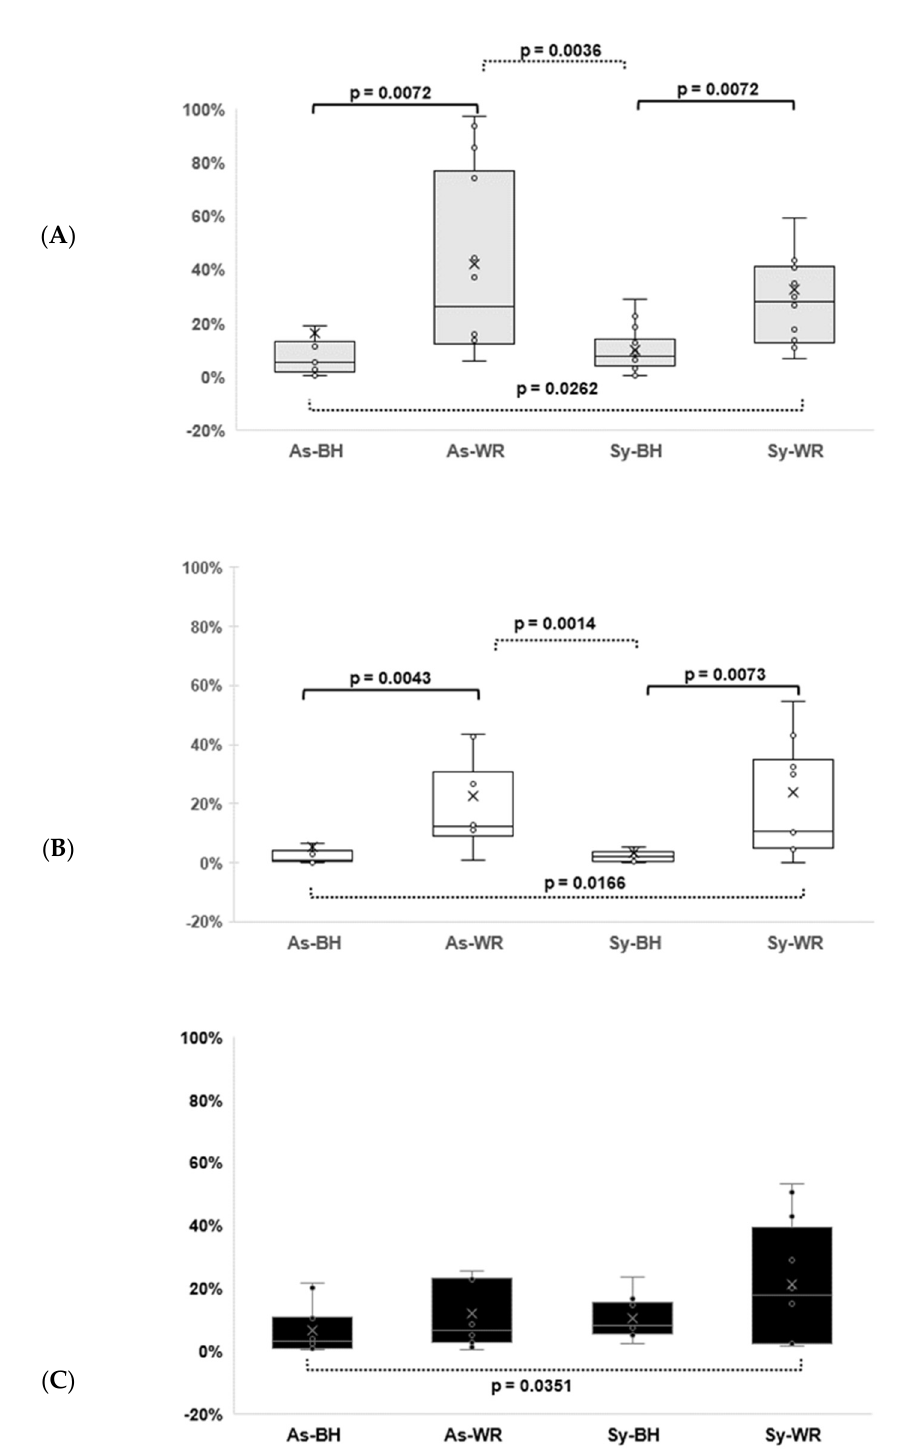
Figure 6. Relative abundance of three different guilds of pathotrophs (calculated for the total 622 fungal ASVs that were assigned to a trophic mode) in grapevine wood of the four studied symptom categories. ( A ): GTD-related pathogens; ( B ): fungi causing white rot; and ( C ): plant pathogens. Means and standard errors ( n = 12) are shown for symptoms (As-BH, As-WR, Sy-BH and Sy-WR). Significant differences between two categories are shown with p -values < 0.05, according to the Mann–Whitney (Wilcoxon)